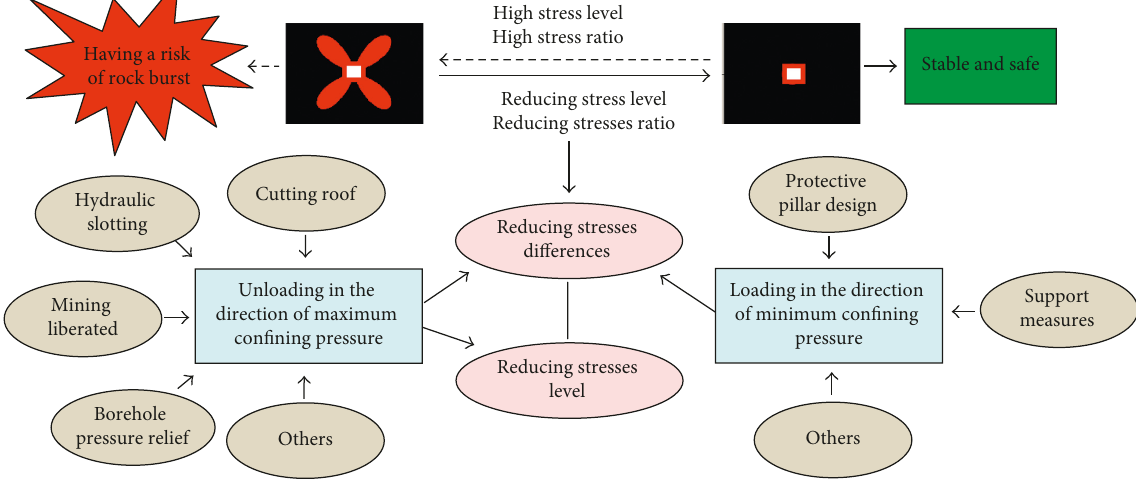
Figure 14: Stress preventive methods of rockburst in